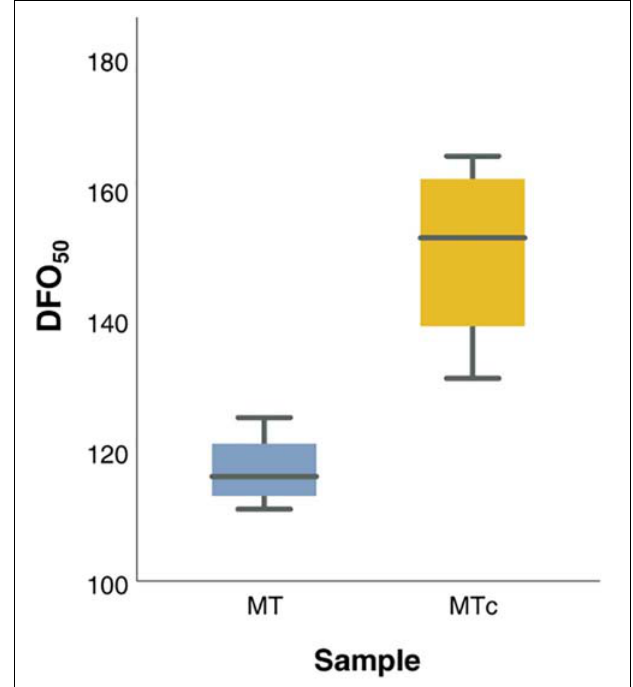
and DFO from the other variables ( Figure 2 ). As a consequence, FIGURE 3 | Box-plot distribution of DFO 50 values of MT (blue) and MTc (yellow) samples during the 4 years of investigation.